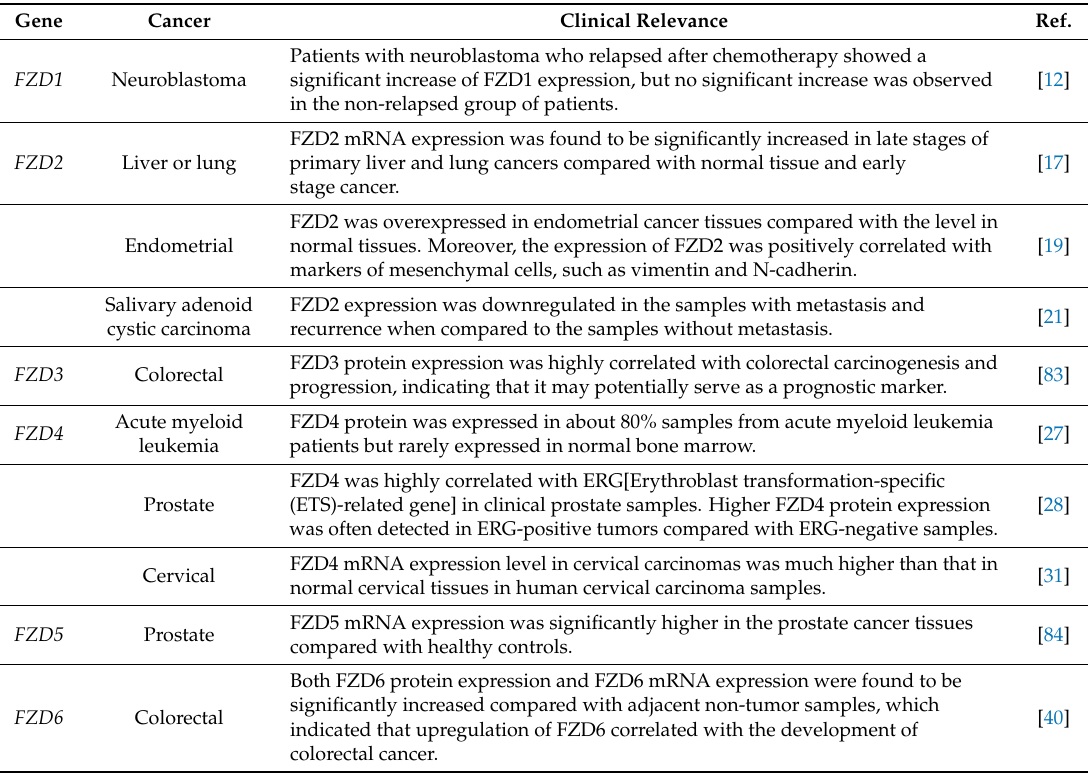
Table 1. The clinical relevance of FZDs in different